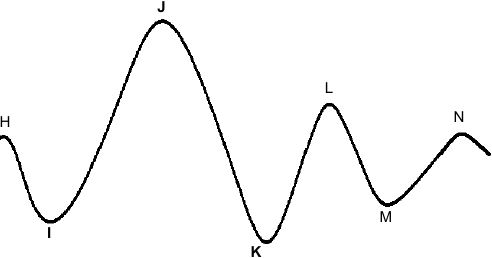
Figure 7. A characteristic ballistocardiogram waveform for one heartbeat. Each peak is denoted with letters H-N. The most relevant peaks related to physiological functions are denoted as I, J, and K.